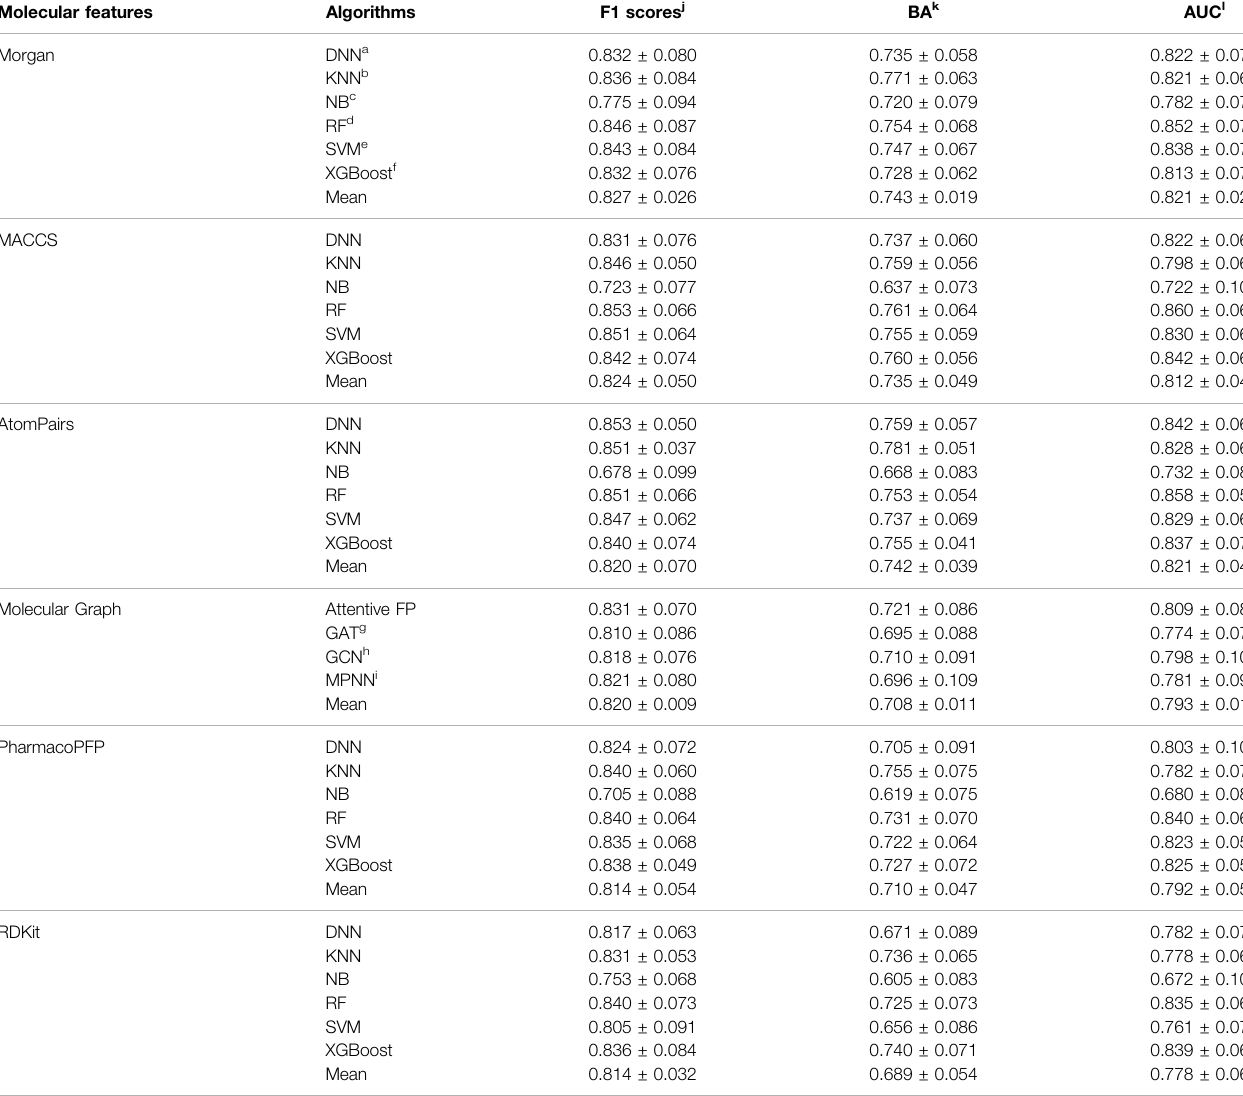
TABLE 2 | Optimal models in different datasets and the evaluation of test